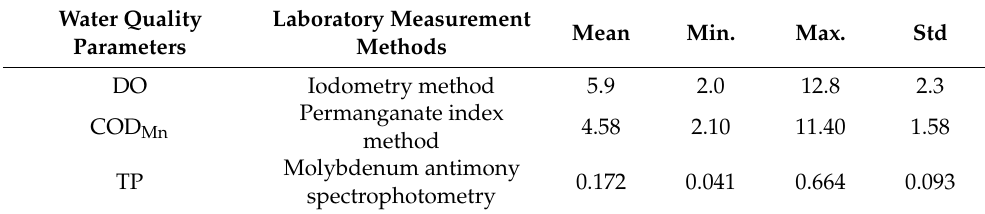
Table 2. Laboratory analysis methods and statistics of DO, COD Mn , and TP. Water quality parame-